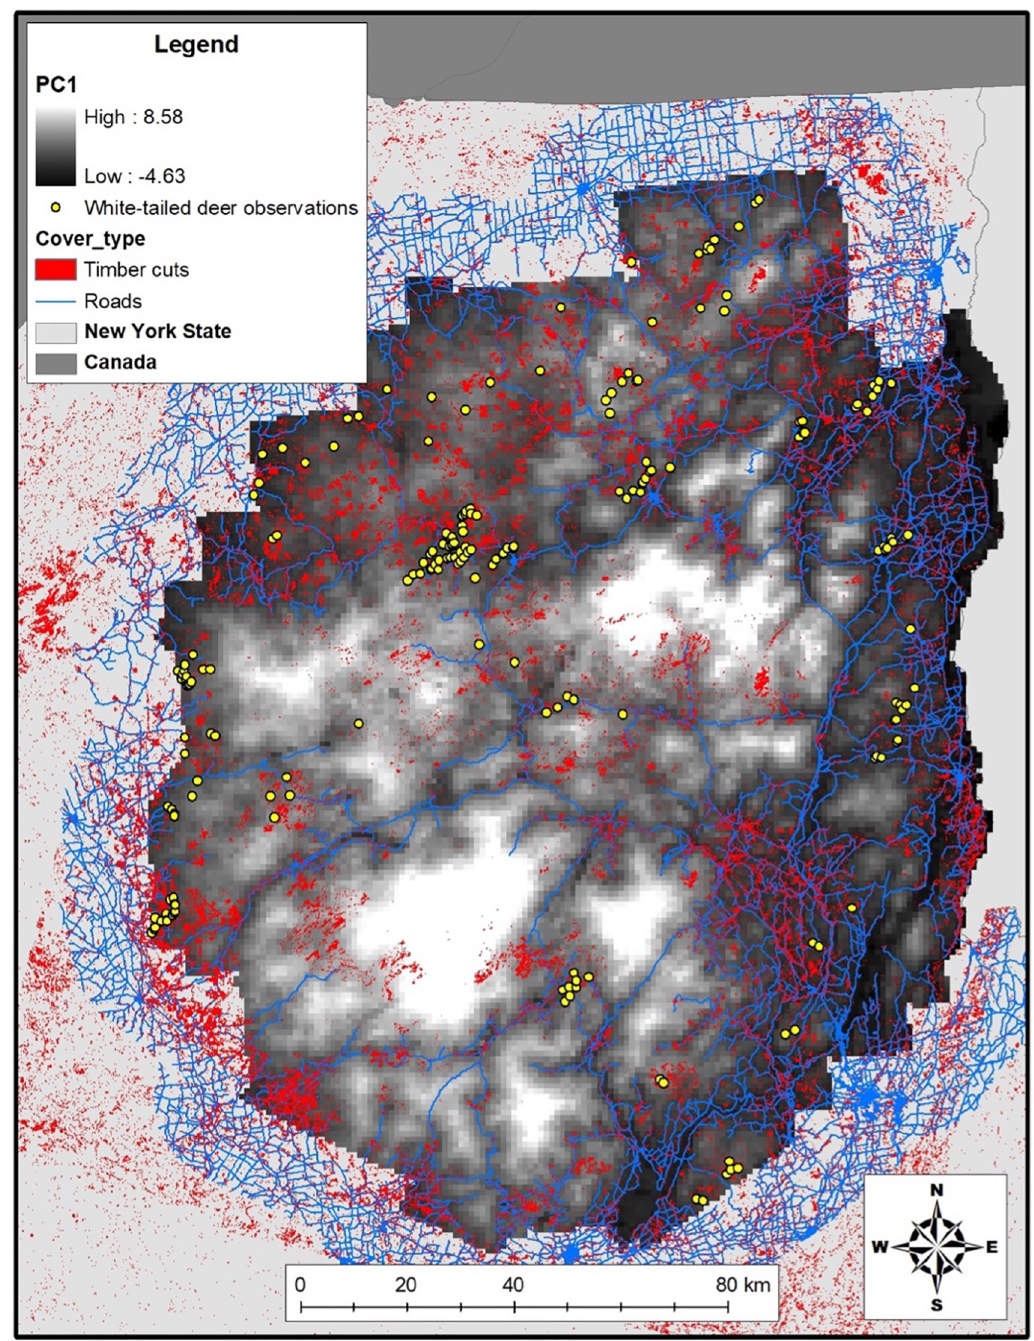
Fig 2. Observations of white-tailed deer made during aerial surveys (yellow circles), roads (blue lines), and timber cuts (red polygons) overlaid on a surface map of PC1 representing thermal cover and foraging areas for deer across the Adirondack Park, New York, USA, during winter 2015–2016. Low PC1 values represent areas with low elevation, decreasing days with snow cover, and increasing proximity to timber cuts, developed cover, and agriculture.